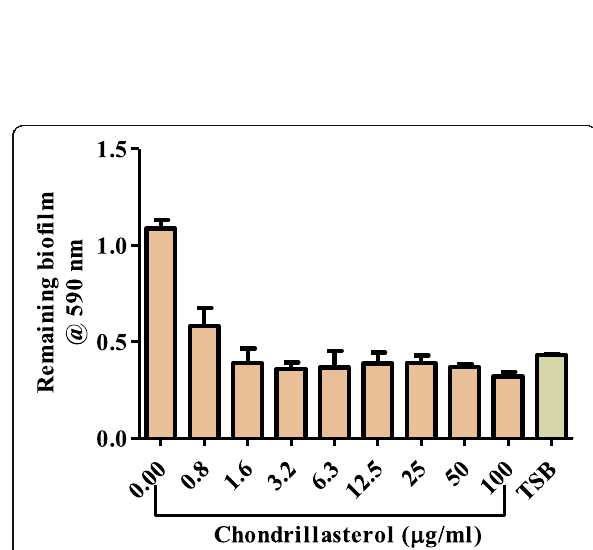
The asterisks (*) indicate statistically significant differences with the